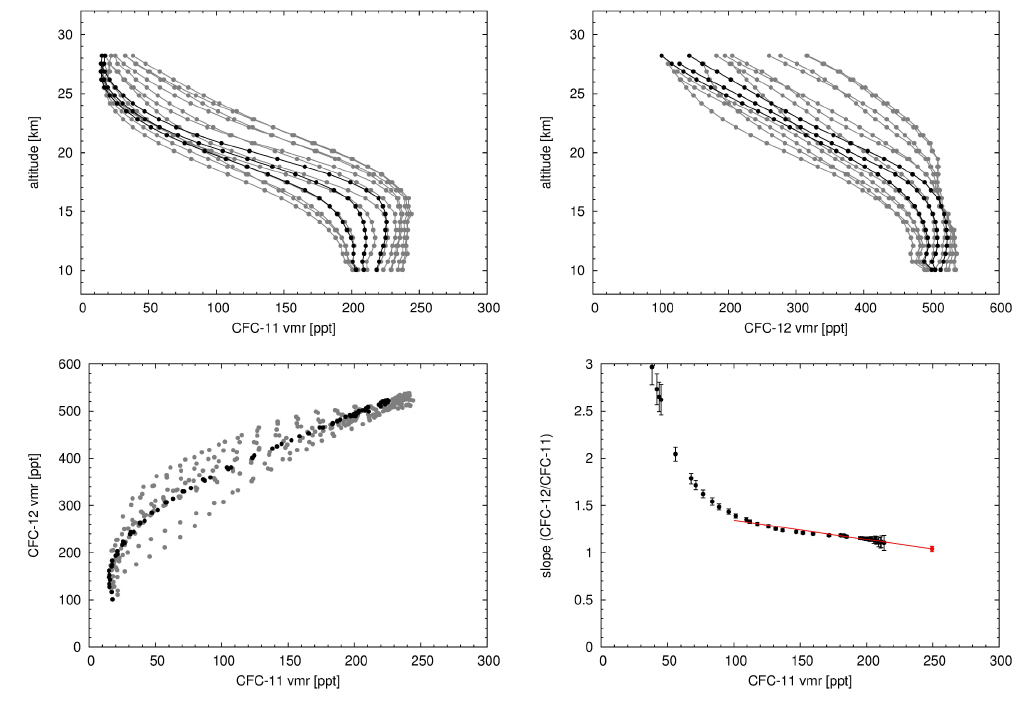
Figure 5. Same as Fig. 4, but for HIRDLS data.